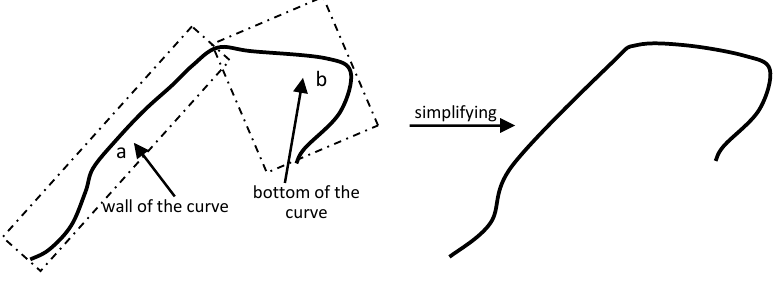
Figure 12. The method of simplifying large U-shaped curves.